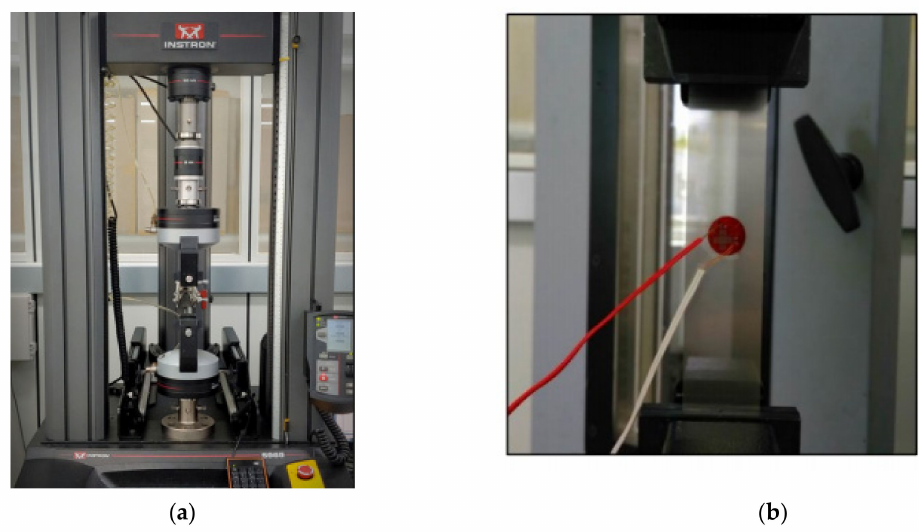
Figure 13. ( a ) UTM. ( b ) Two-axis strain